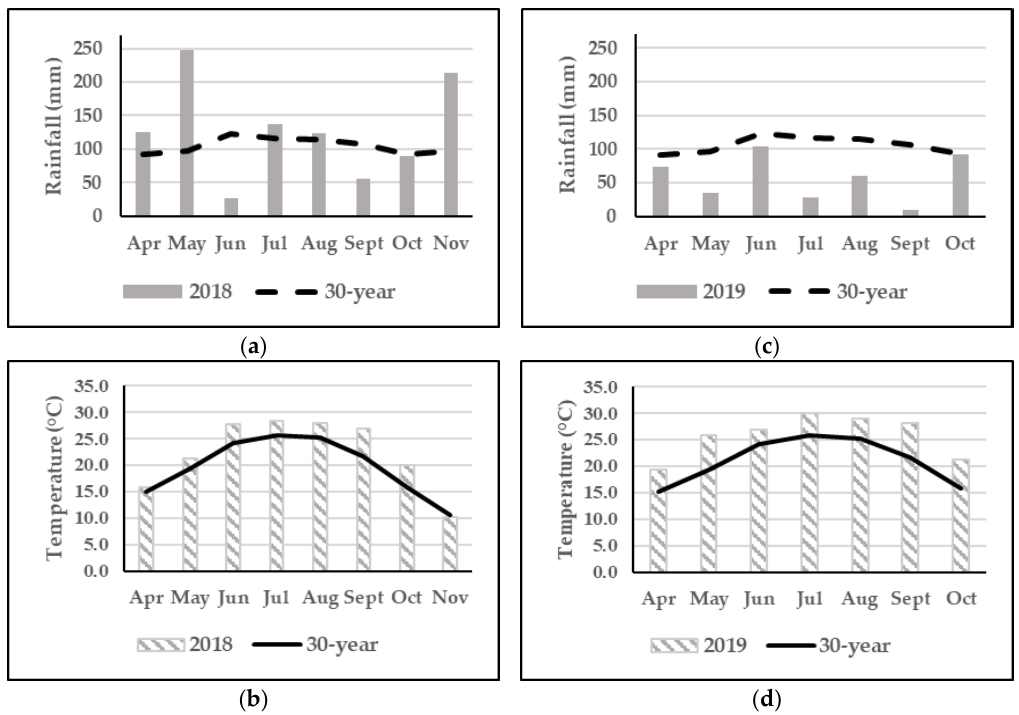
Figure 1. Total monthly precipitation (mm) and mean monthly temperature (°C) and 30-yr historical average for Sandy Springs, SC, during the 2018 ( a , b ) and 2019 ( c , d ) growing seasons.